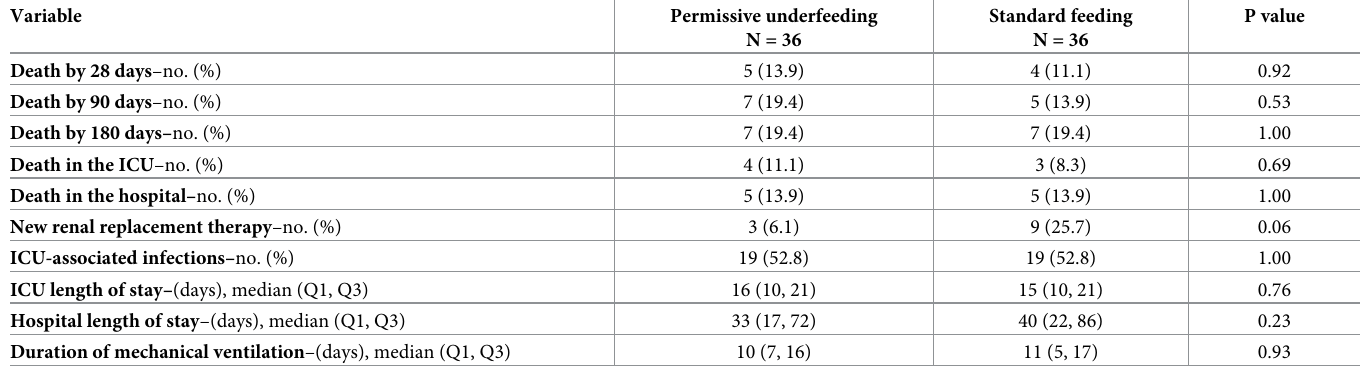
Table 3. Outcome data in patients in the permissive underfeeding and standard feeding.